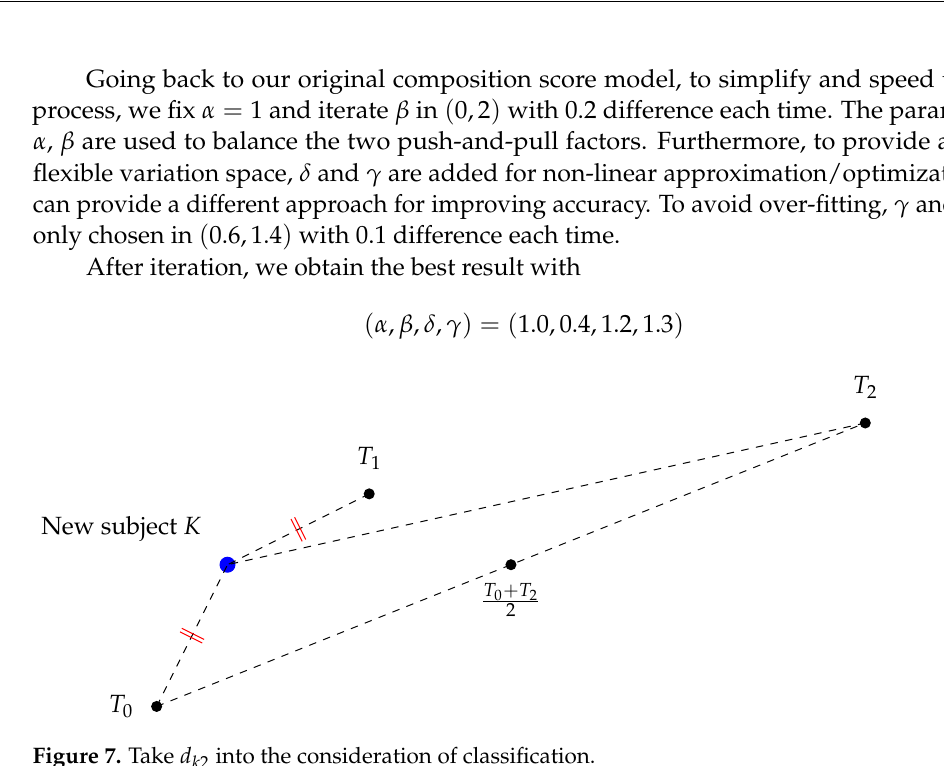
Figure 7. Take d k 2 into the consideration of